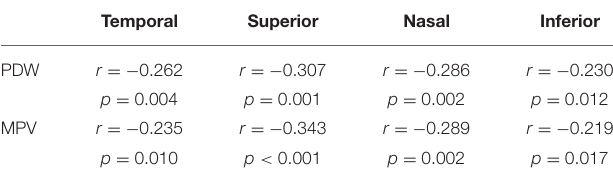
TABLE 4 | Correlation between platelet parameters and RNFL thickness measurements by quadrants in POAG.